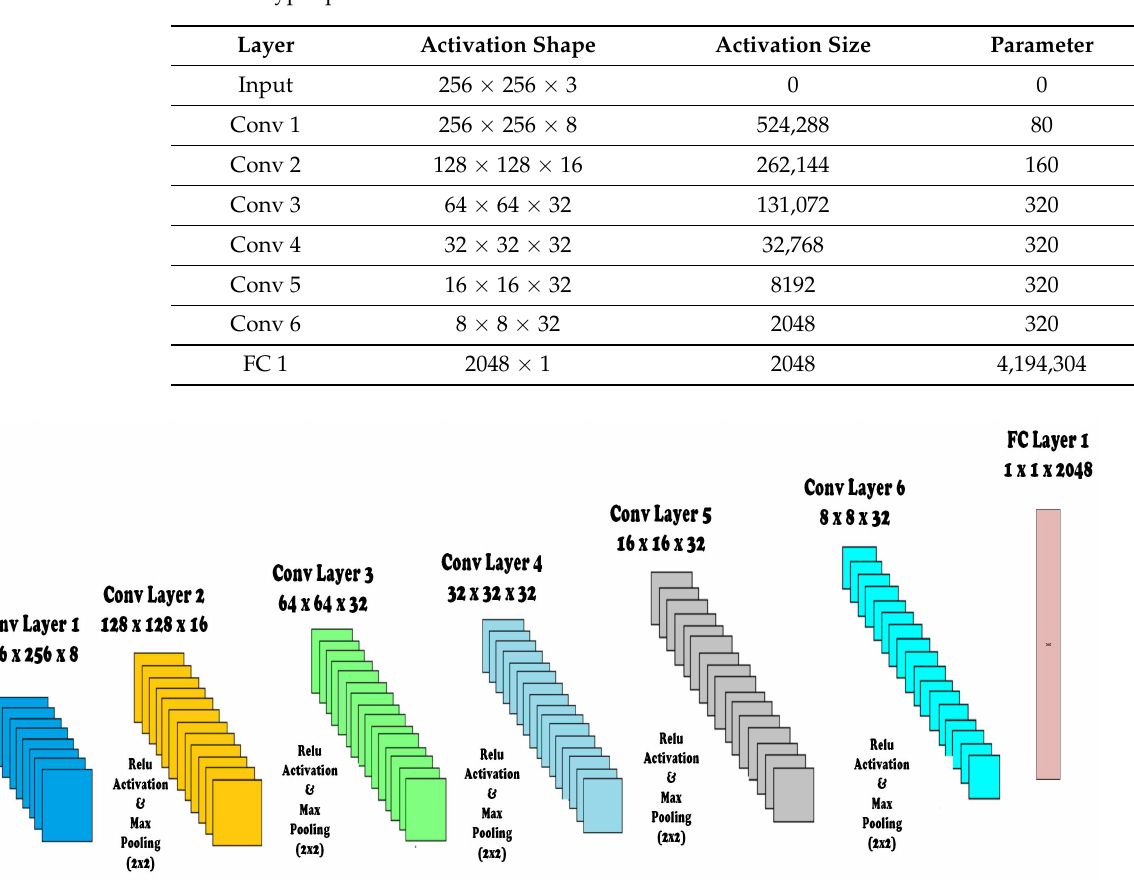
Table 2. Hyper parameters of the CNN.